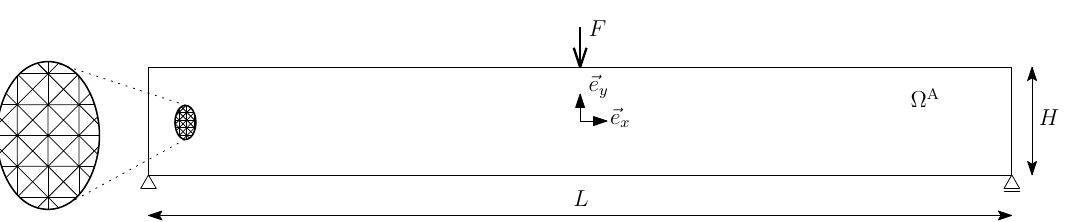
Figure 1. Geometry and boundary conditions of the considered three-point-bending test with a close-up of the full lattice representation.